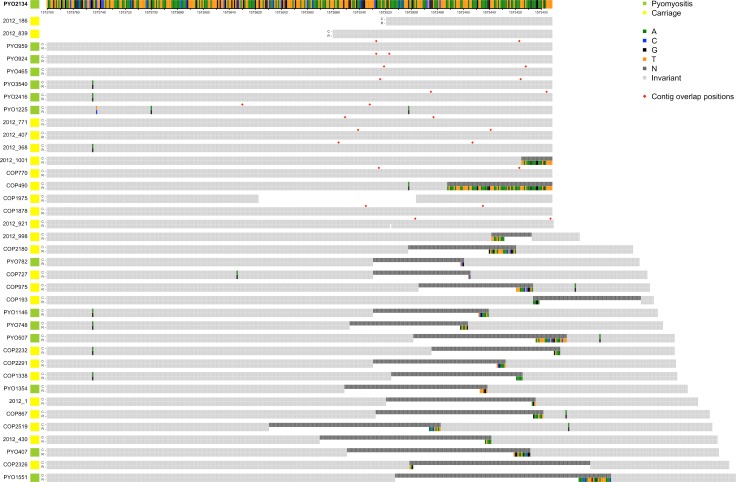
Alignments of reference genome PYO2134 assembly (R) with 37 de novo assemblies of Illumina short-read sequencing (C) which feature either ambiguities (Ns) or contig boundaries in the region 389 bp upstream of PVL coding sequence.Contig boundaries, when overlapping, are marked with a red diamond. Ns in the assembly are marked in dark grey. Polymorphisms are colour-coded by base.